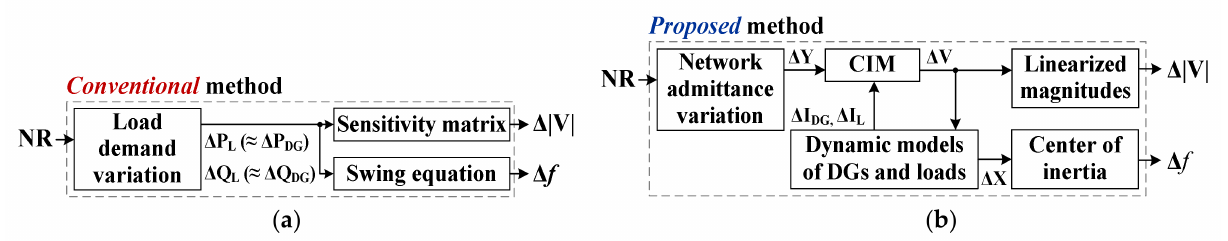
Figure 7. The ( a ) conventional and ( b ) new methods for NR